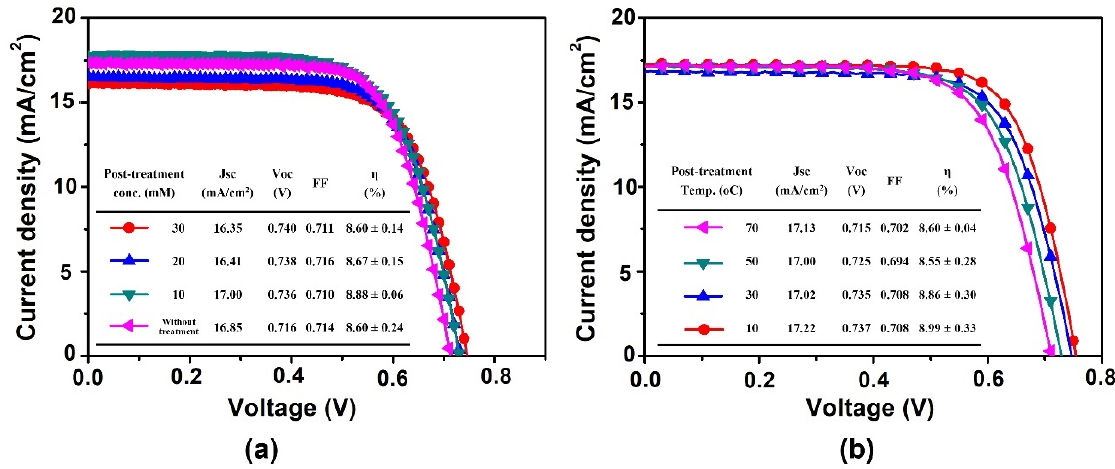
Figure 4. J-V curve of 5 cm × 5 cm DSSC module with TiCl 4(aq) post-treatment at ( a ) different concentrations and ( b ) different temperatures.